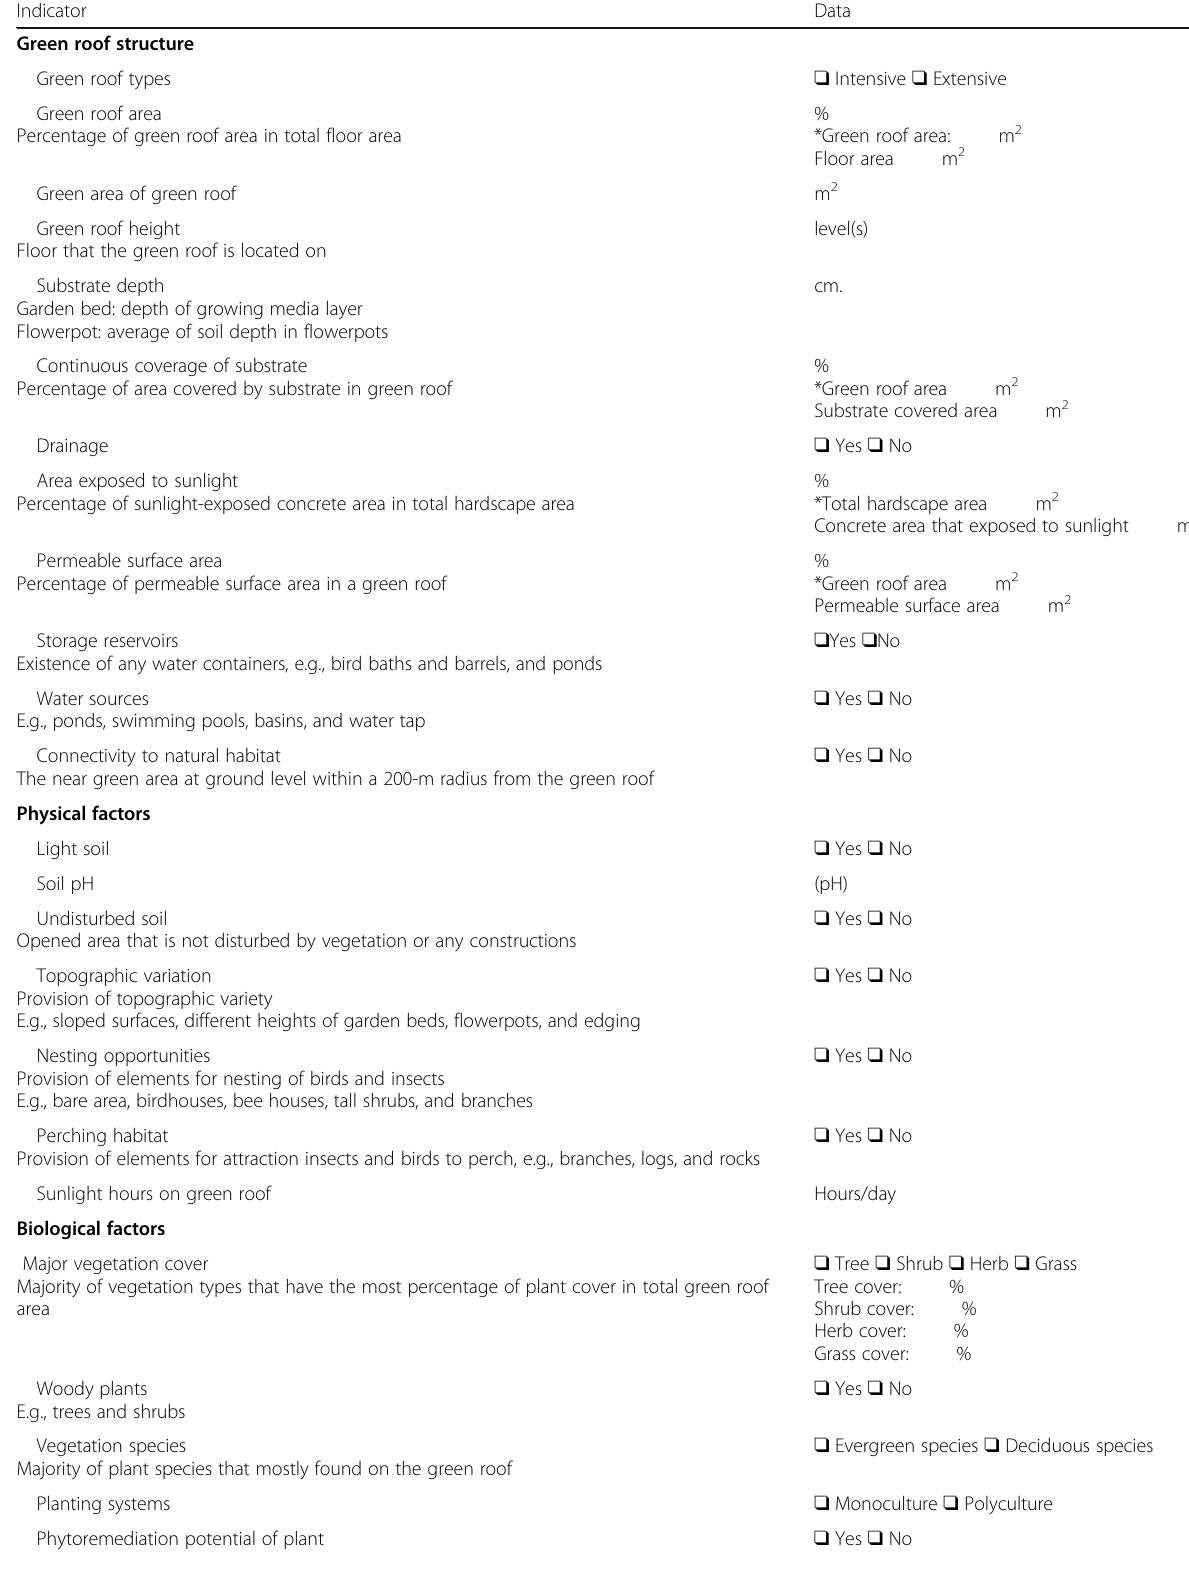
Table 2 The RAC for assessing